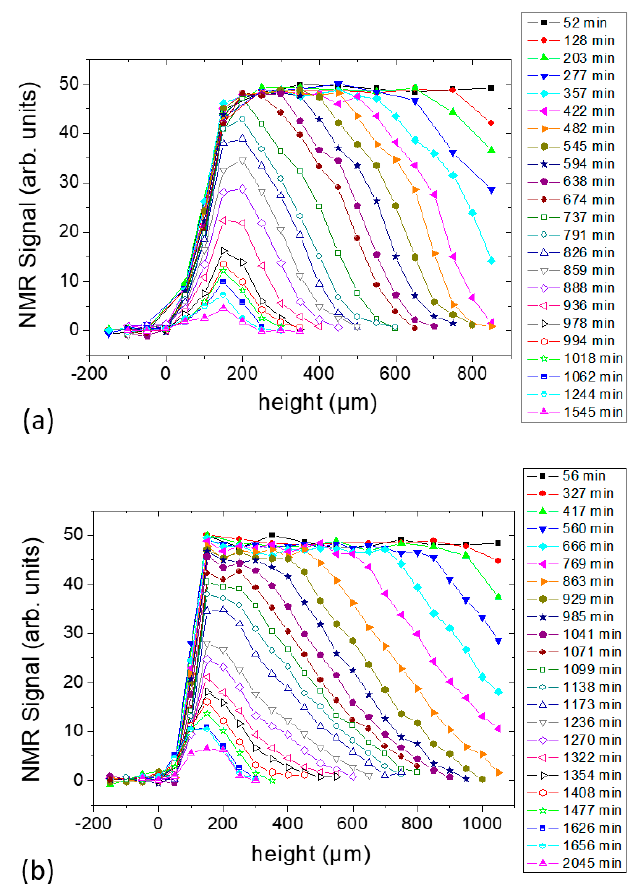
Figure 3. NMR profiles of the starch–water system at different drying times: ( a ) Sample c containing 1% starch in H 2 O ( w / v ) and ( b ) Sample d containing 5% starch in H 2 O ( w / v ). Each sample contained glycerol (20 g/100 g of starch) as a plasticizer.